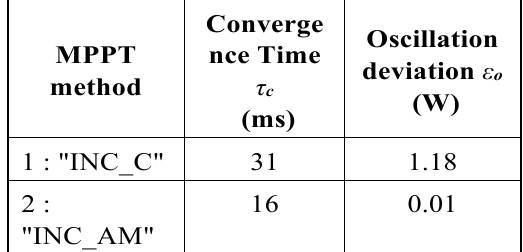
Table 4: Calculated Performance